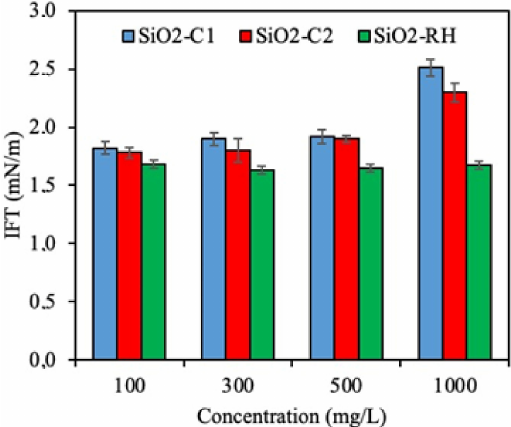
Figure 10. Interfacial tension measurements for the AGC:bio-ethanol (80:20) and dosages of 100, 300, 500, and 1000 mg · L − 1 of silica-based nanoparticles from Sigma-Aldrich (SiO 2 -C 1 ), silica-based nanoparticles in-house synthesized from rice husks (SiO 2 -RH), and commercial silica-based nanopar- ticles (SiO 2 -C 2 ). Measurements at reservoir temperature of 47 ◦ C by spinning drop equipment. The error bars correspond to their standard deviation.